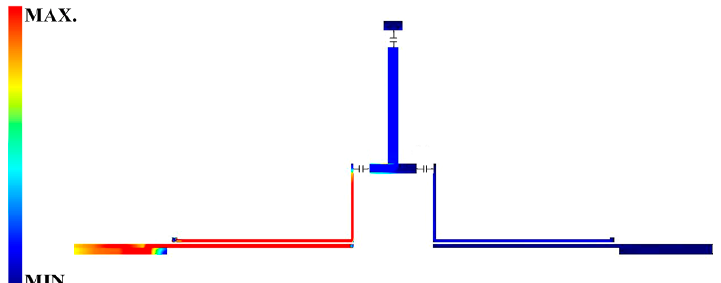
Figure 5. Current density distribution of the proposed filter in switched-off state.